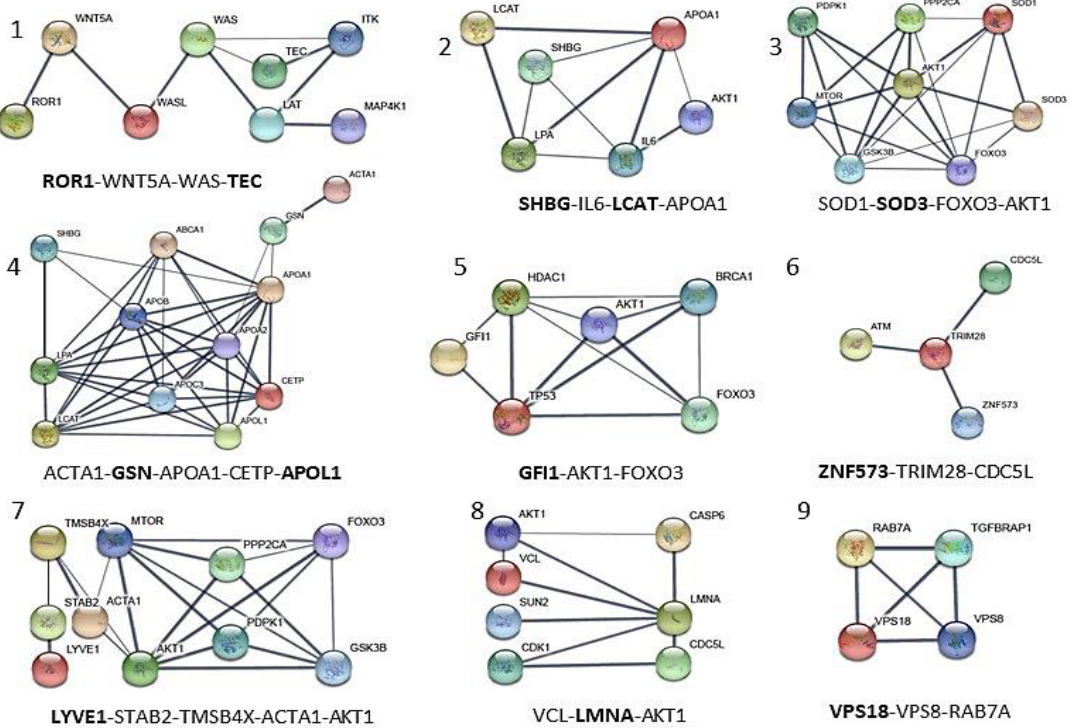
Figure 5. Local network interaction generated for each of the 12 proteins of the panel obtained through STRING upon elaboration of data from Figure 3 and GeneCards databases. The most relevant interconnections based on confidence feature (value of confidence >0.700 and p < 1.0 × 10 − 16 ) are also visualized in Figure 6. Each local network (1–9) shows the relevant protein connections written in the bottom, and proteins of the MS panel are reported in bold. SOD3 and VPS18, taken from Table S5a, are added as internal control proteins.